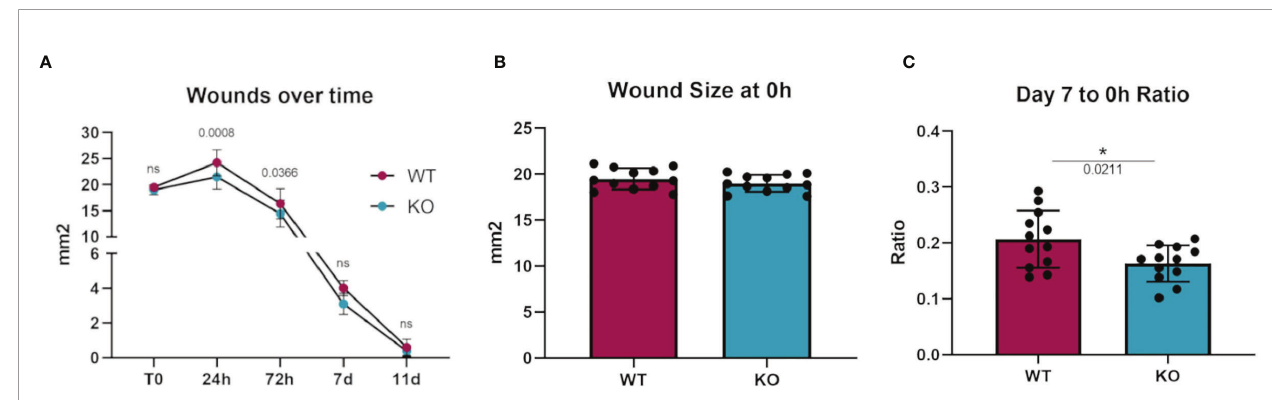
FIGURE 5 | Increased wound closure rate in Dgka -/- mice compared to WT. (A) Area measurement of burn wounds in KO and WT mice compared over time. (B) Sizes of wounds from both groups are comparable at time zero. (C) One week post injury, wound sizes in KO mice are smaller relative to those at T0. Each data point represents a single burn, with two burns on the each of n = 6 mice per group. Error bars: SD. *p < 0.05; ns, not signi fi cant. Two-way ANOVA with Sidak post- hoc test (A) , Student ’ s t-test (B, C)